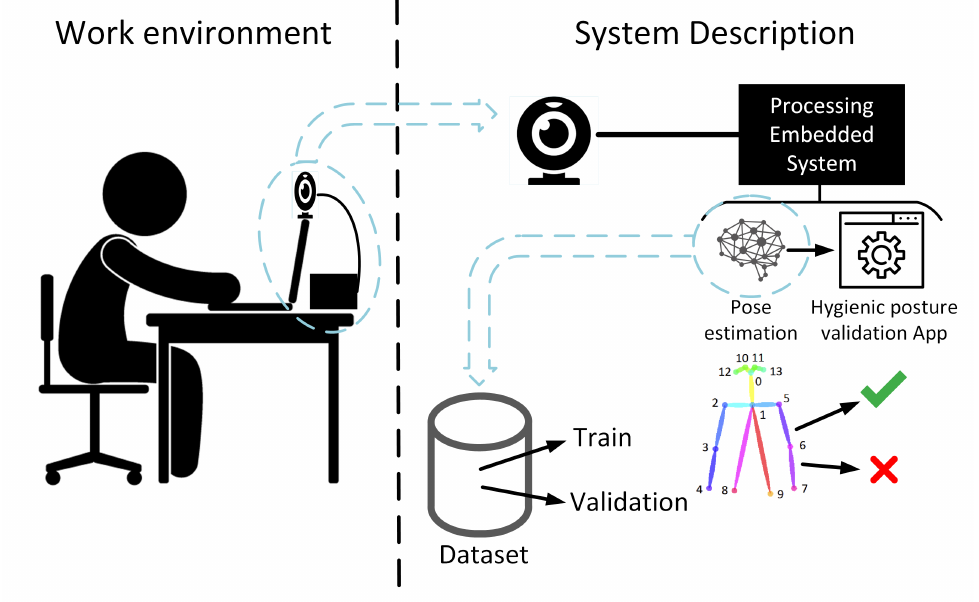
Figure 1. Application environment and global system